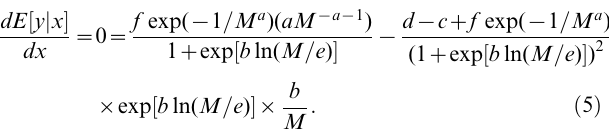
Table 2. Parameterizations of the Cedergreen et al. model [2] to estimate particular dosage effects.